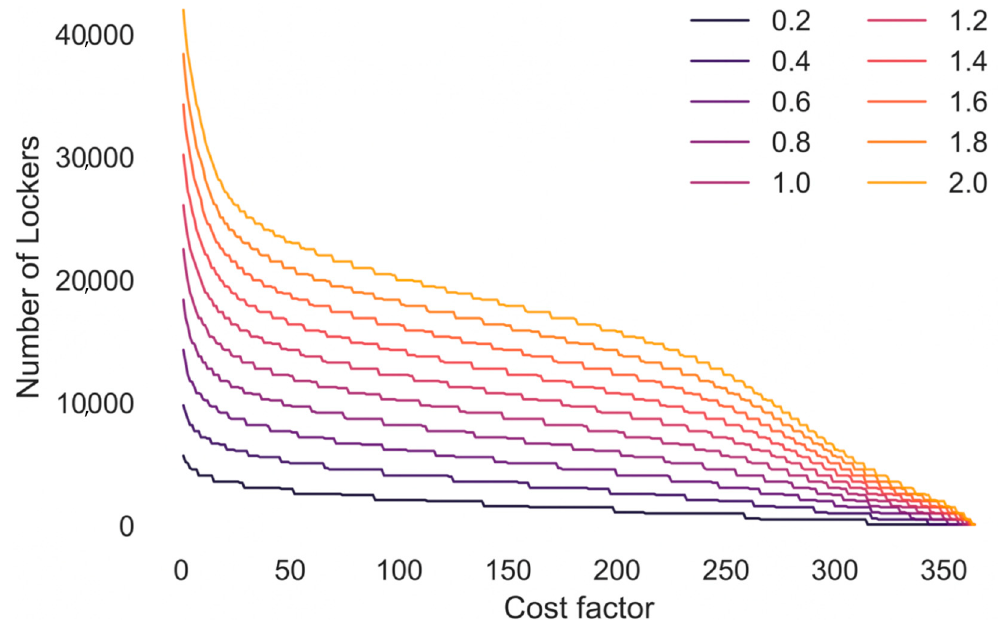
Figure 10. Optimal number of lockers depending on the costs and variation in the demand for parcel lockers (512 CDPs).